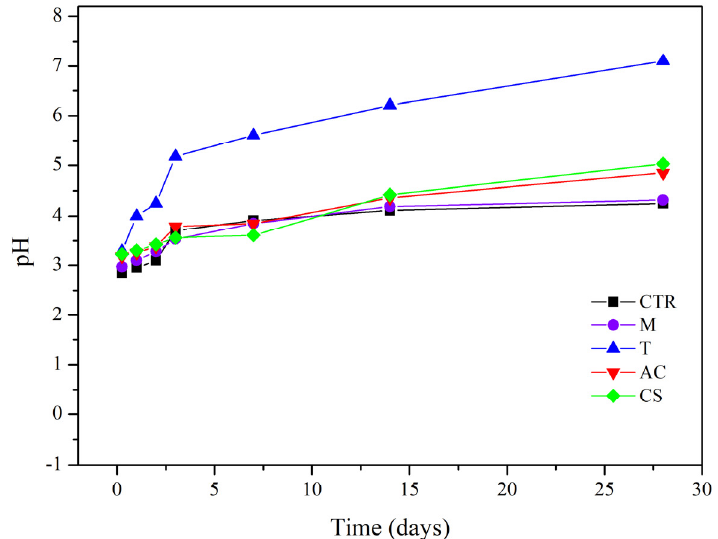
Figure 5. Effluent pH breakthrough curves in column leaching test with and without amendments at a flow rate of 1 mL/min condition (CTR: control; M: magnetite; T: talc; AC: activated carbon; CS: cornstarch).